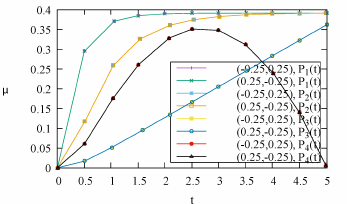
Figure 9. Solution µ at points ( − 0 . 25 , 0 . 25) , (0 . 25 , − 0 . 25) for Problem 2 of isotropic homogeneous material.